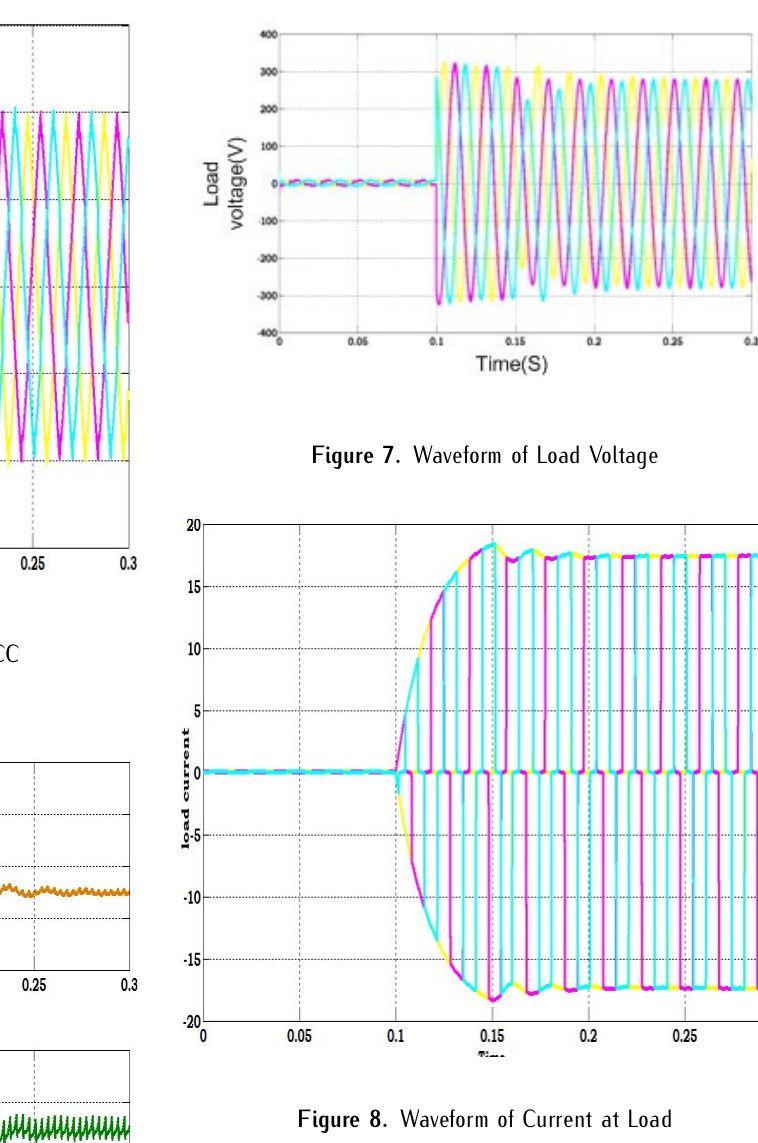
Figure 8. Waveform of Current at